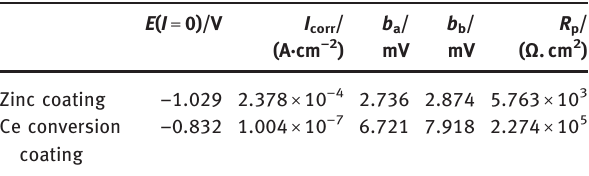
Table 2: Electrochemical parameters of Tafel